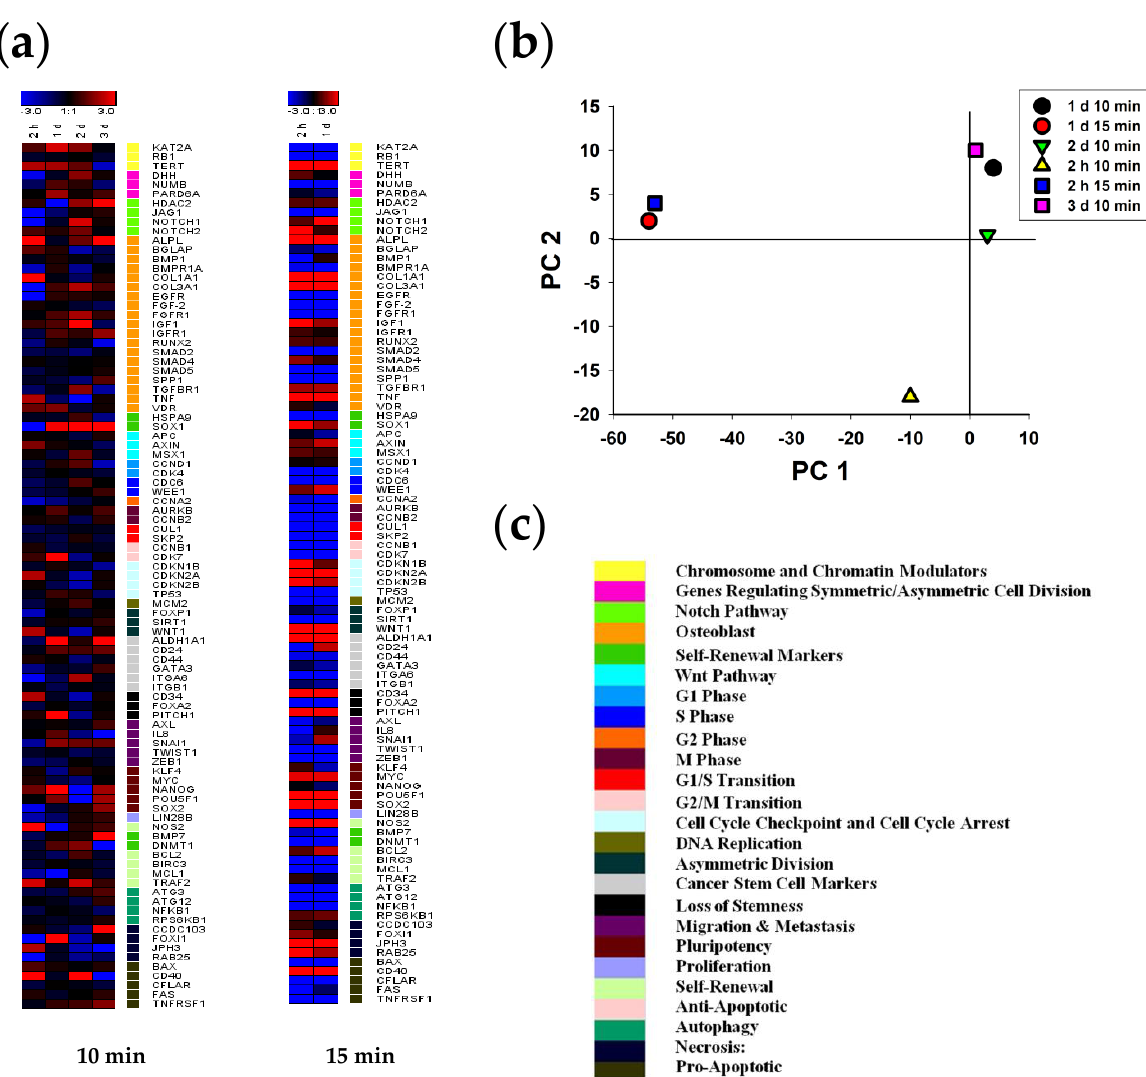
Figure 7. Heat map of gene expression in MNNG/HOS cells treated with 10 and 15 min CAAP irradiation after 2 h, 24 h, 48 h and 72 h of incubation (the deviations are shown in a logarithmic scale with a base of 2): ( a ) the intensity scale of the standardized expression values ranges from −3 (green: low expression) to +3 (red: high expression, with 1:1 intensity value (black) representing the control (non-treated); ( b ) principal component analysis (PCA) of qRT-PCR data for MNNG/HOS cells treated with 10 and 15 min CAAP irradiation after 2 h, 24 h, 48 h and 72 h; ( c ) cluster groups of genes and their functionality. The belonging of genes to different clusters and markers is shown using the color scale which is to the right of the diagrams. A validated database for gene ontology annotations is presented in Table S1.